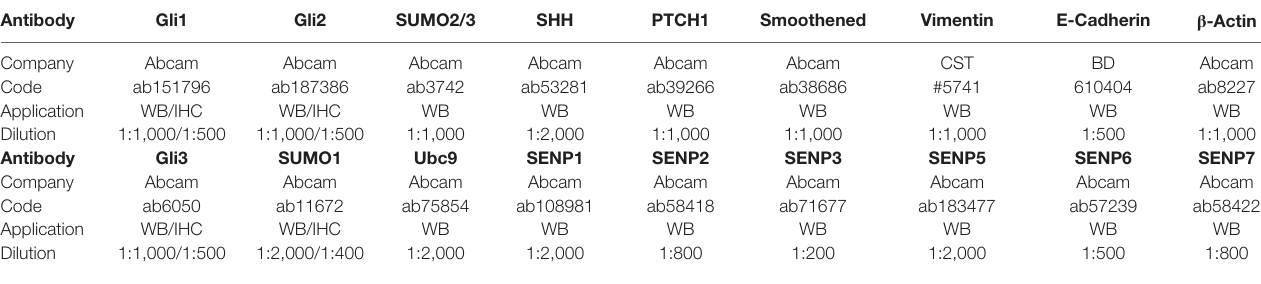
TABLE 1 | The information of all related antibodies in this study. Antibody